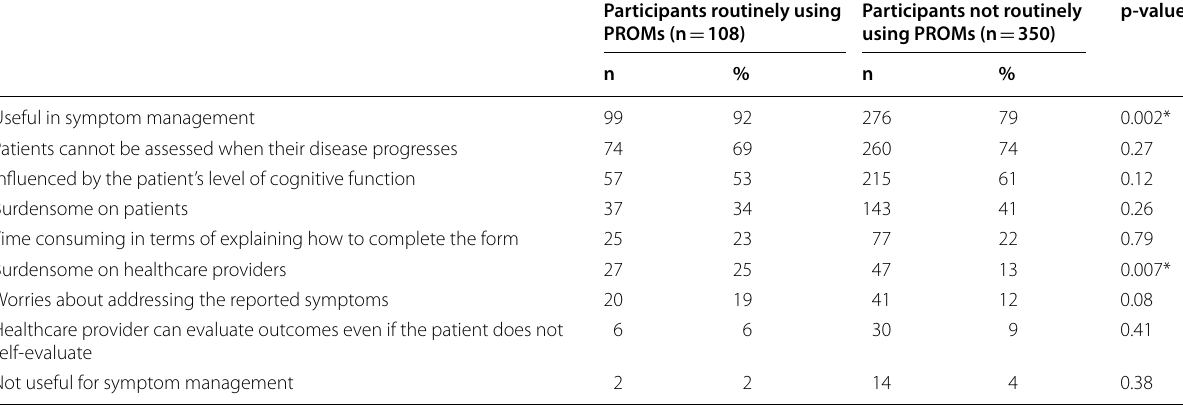
Table 3 Opinions about PROs of healthcare providers in institutions that routinely use PROMs